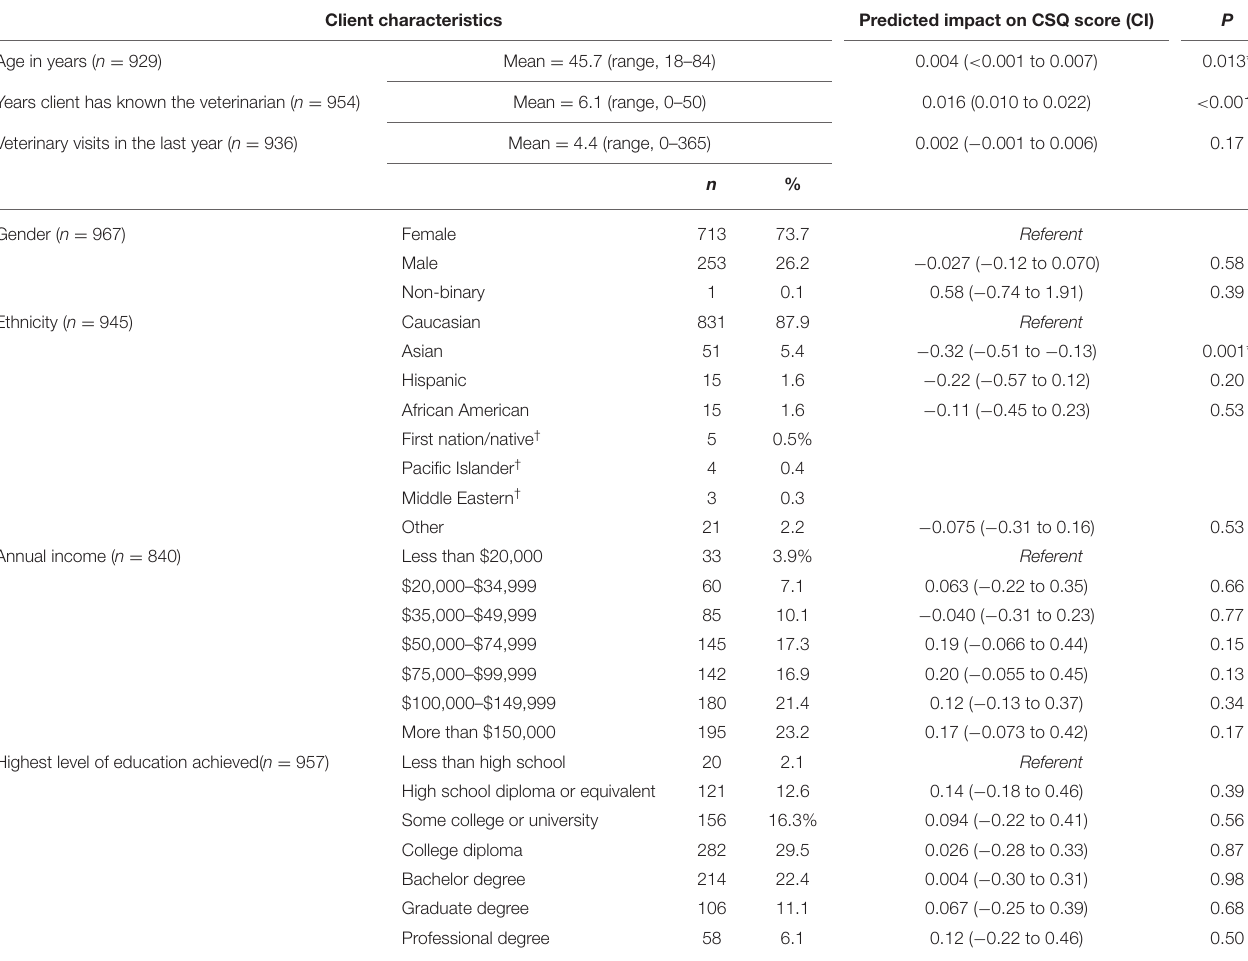
TABLE 3 | Description of clients who completed the Client Satisfaction Questionnaire (CSQ; n = 995) and predicted impact of client variables on CSQ score in univariable linear